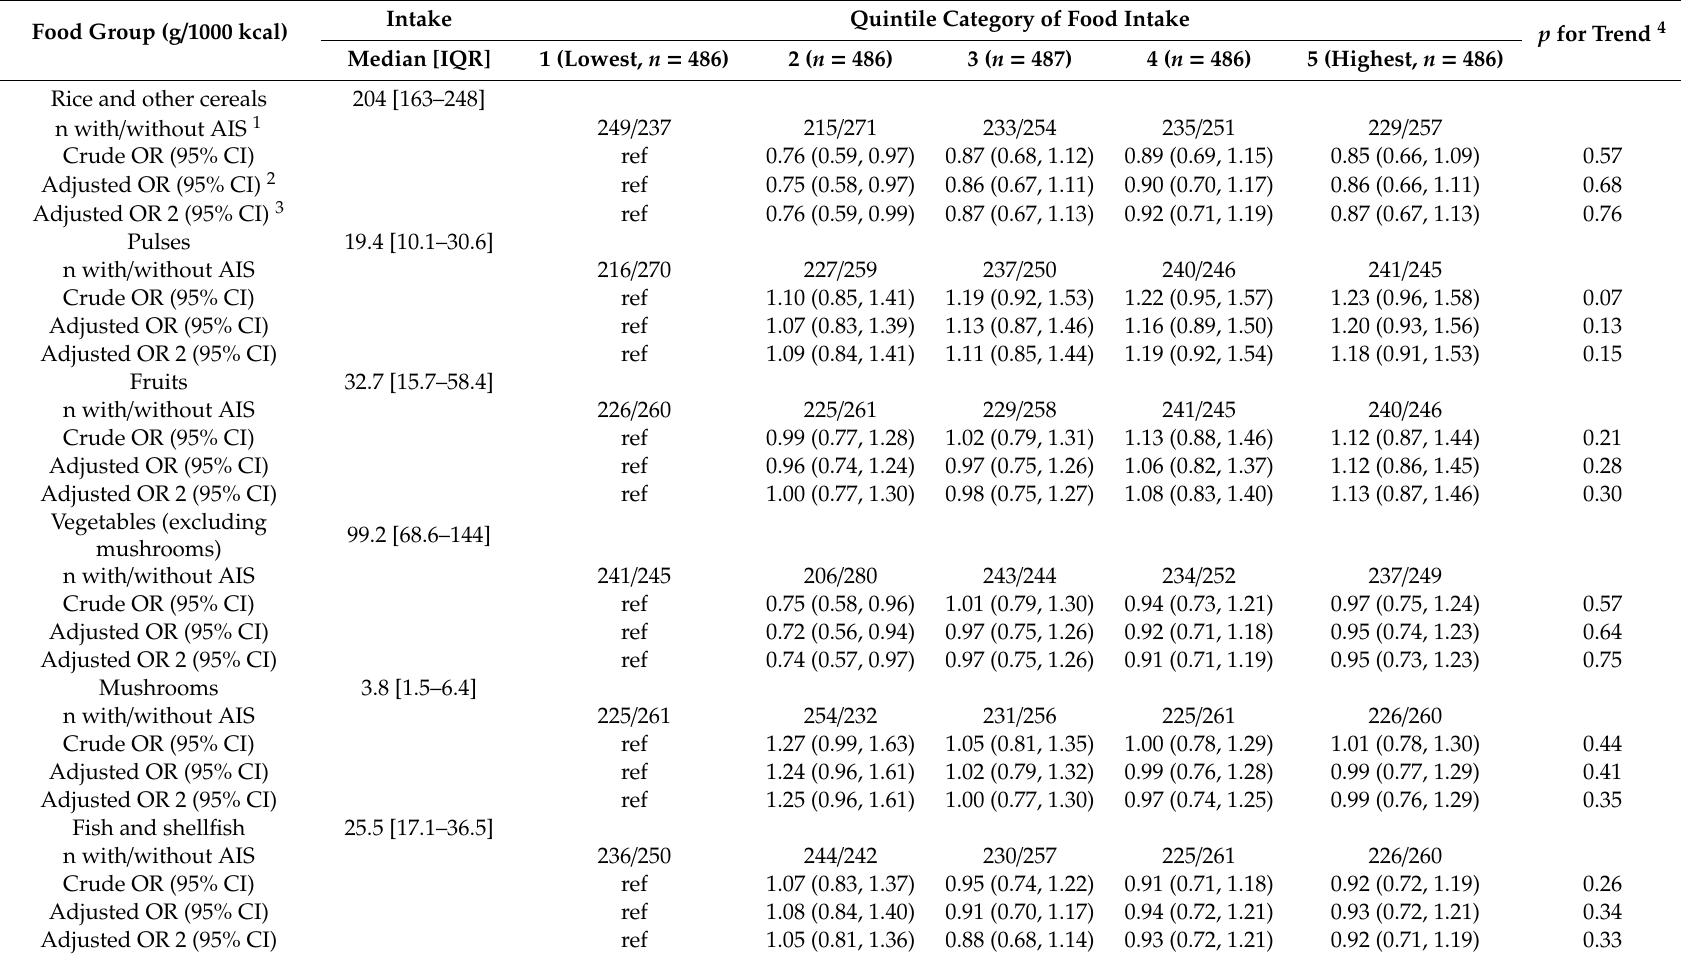
Table 3. Multivariate-adjusted odds ratios and 95% confidence intervals for adolescent idiopathic scoliosis by quintile of food group intake in 2431 Japanese female junior high school